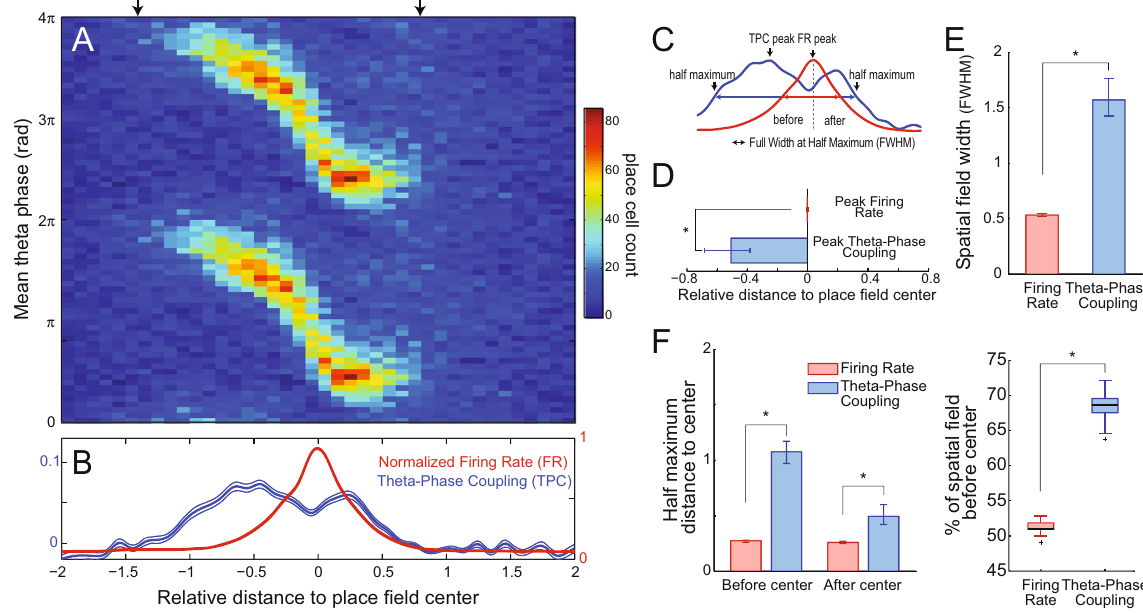
Figure 3. Asymmetry of the temporal code for space by hippocampal place cells. ( A ) Histogram of mean spiking phase. At each position, individual place fields contribute with one count to the phase bin in which the mean spiking of their place cell occurs. Arrows mark the region where the distribution of mean spiking phases statistically differs from the uniform distribution, indicating coordinated theta-phase coupling across cells. ( B ) Theta-phase coupling strength (TPC, blue) and mean normalized firing rate (FR, red) as functions of space. Thin lines denote 99% confidence intervals. The TPC curve was corrected by subtracting chance values (see Materials and Methods). ( C ) Scheme describing the identification of peak and half maximum values as well as of the full width at half maximum (FWHM) for TPC and FR curves. ( D ) Mean relative distance of TPC and FR peaks, showing that place cells are maximally modulated by theta phase before their peak firing rate. ( E ) Comparison of spatial field width when defined by the FWHM of FR vs TPC. ( F ) Relative distances of FR and TPC half maximum values to the place field center (left) and percentage of spatial field located before the center when defined by FR vs TPC FWHM (right). In ( D – F ), the error bars denote 99% confidence interval of the mean; * p <